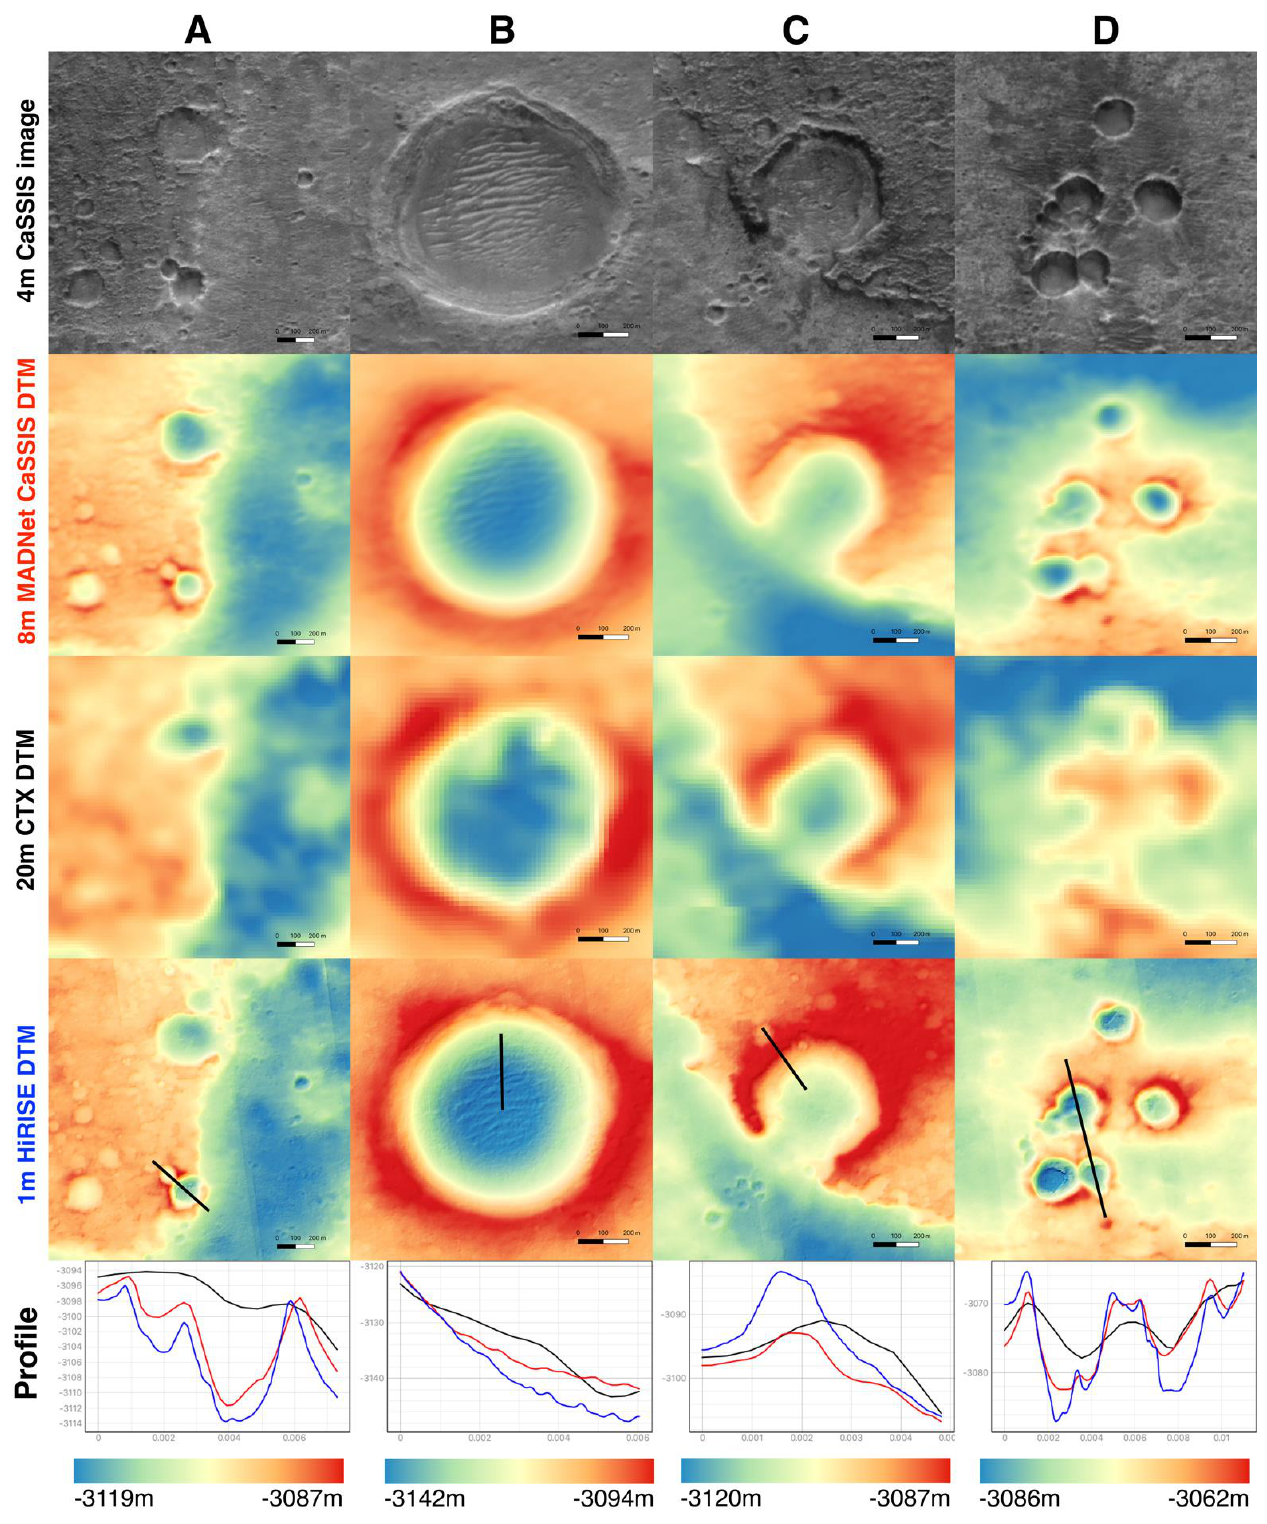
Figure 6. Zoom-in views of the 4 m/pixel CaSSIS image, 8 m/pixel MADNet CaSSIS DTM, 20 m/pixel CTX DTM, 1 m/pixel HiRISE DTM, and measured profiles (location shown on the HiRISE DTMs; black: CTX, red: CaSSIS, blue: HiRISE), for area ( A – D ) (location shown in Figure 5). All DTMs are colour hillshaded. To look into details—please refer to the full-resolution figures provided in Supplementary Materials.